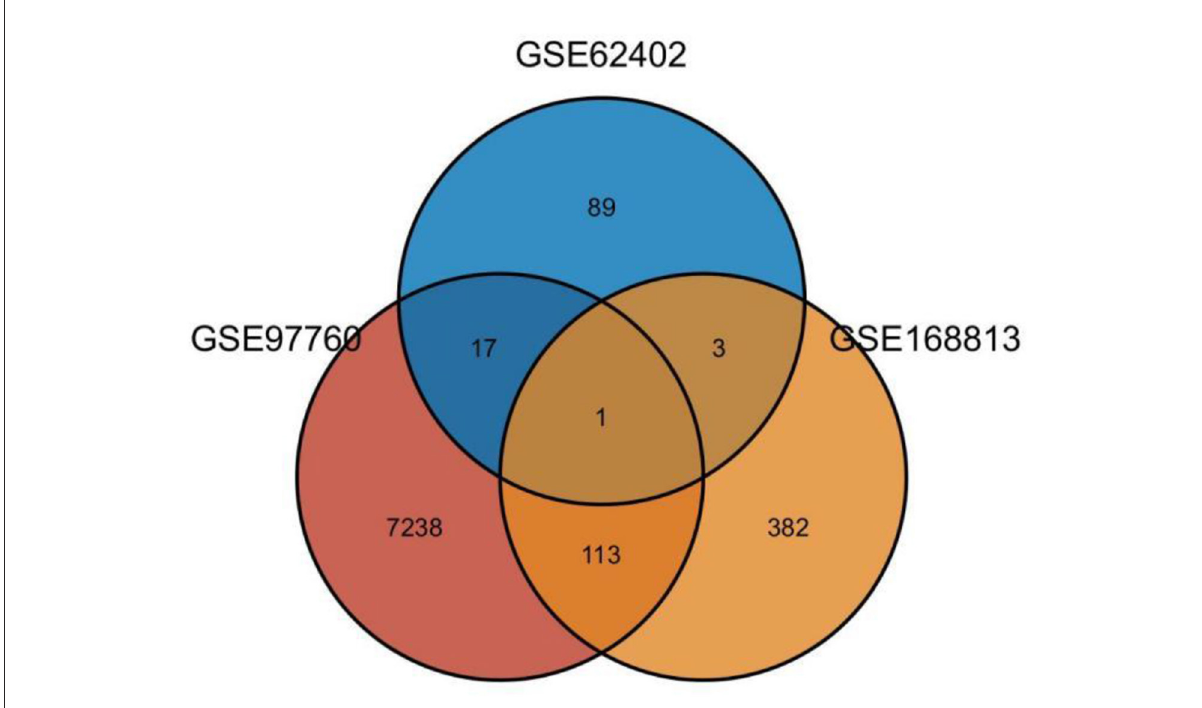
FIGURE2 Venn diagram of differential co-expressed genes in Alzheimer’s disease and osteoporosis in the blood